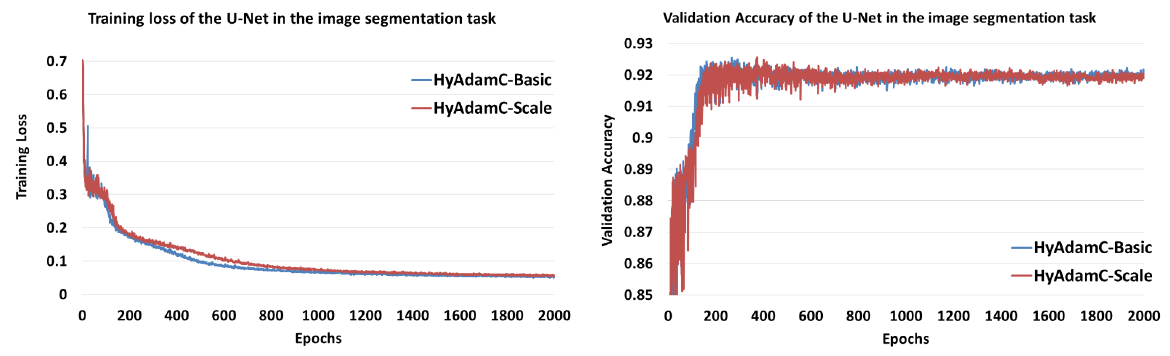
Figure 32. The training loss and validation accuracy curves of HyAdamC-Basic and HyAdamC-Scale in U-Net,